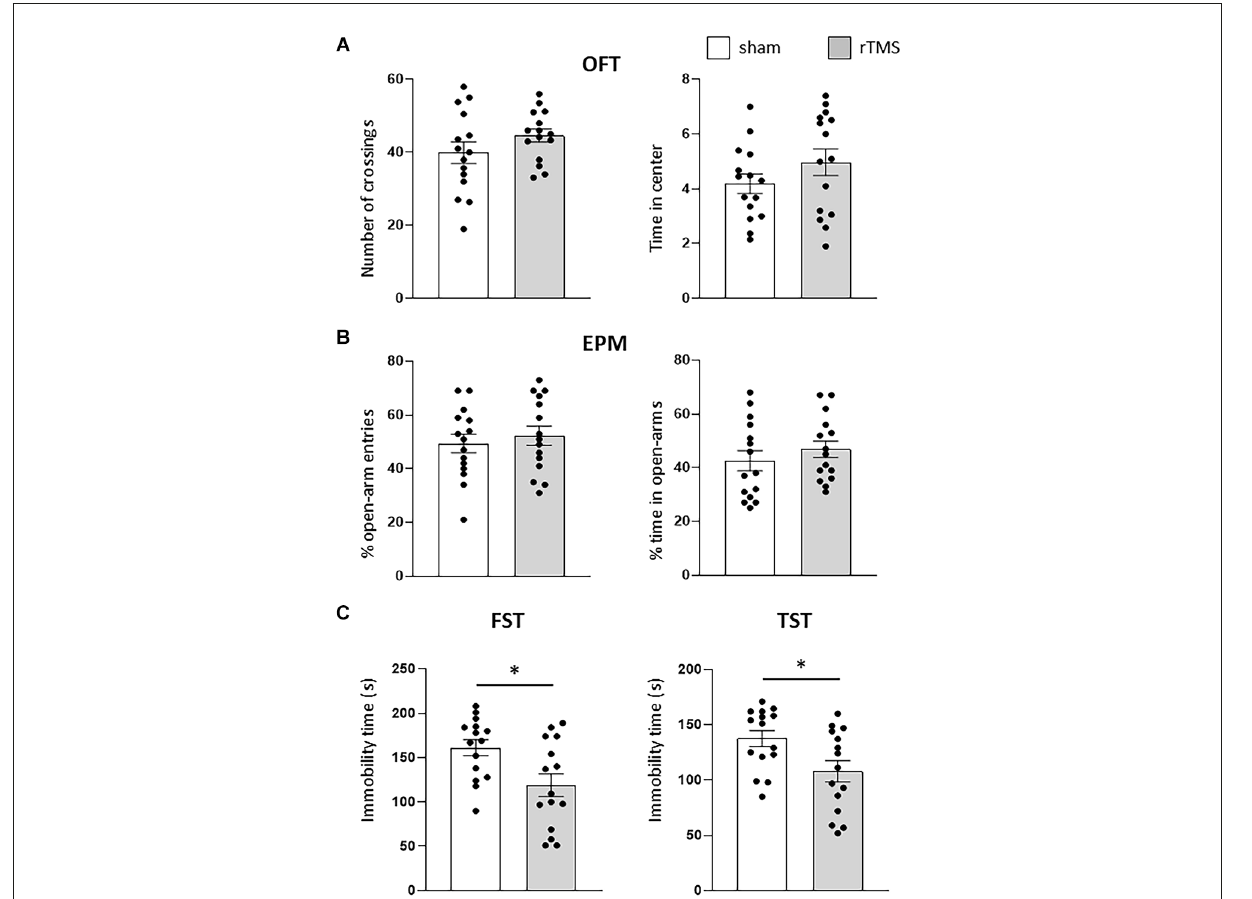
FIGURE2 HF-rTMS modifies depressive-like behavior. In the anxiety-like tests, stimulated and sham animals did not show any difference in the open field test (OFT) (A) , when measuring both the locomotor activity (number of crossing) and time spent in the center of the arena. Similar results were obtained by analyzing the entries and time spent in the open arms of the elevated plus maze (EPM) test (B) . In the depression-like tests, a significant decrease in immobility time was found in both the forced swim test (FST) and in the tail suspension test (TST) (C) . Means ± SE. ∗ p <